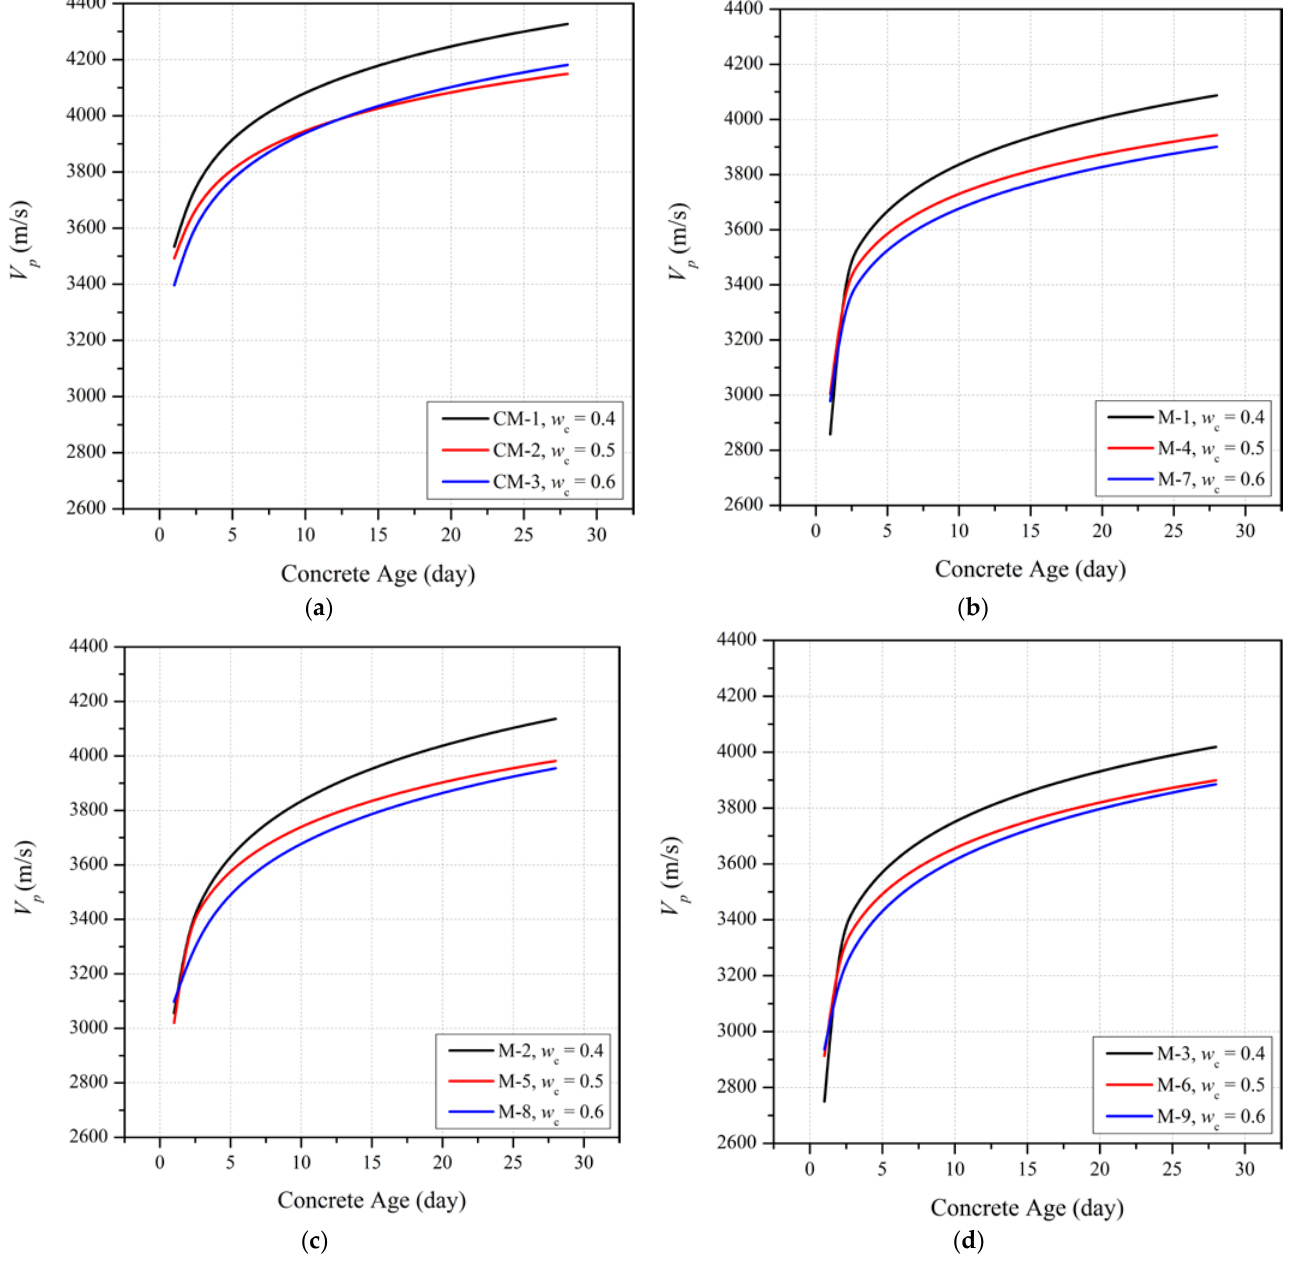
Figure 5. Ultrasonic pulse velocity development for ( a ) OPC mix, slag blended mortars with ( b ) 15% cement replacement, ( c ) 30% cement replacement, and ( d ) 45% cement replacement with GGBFS.